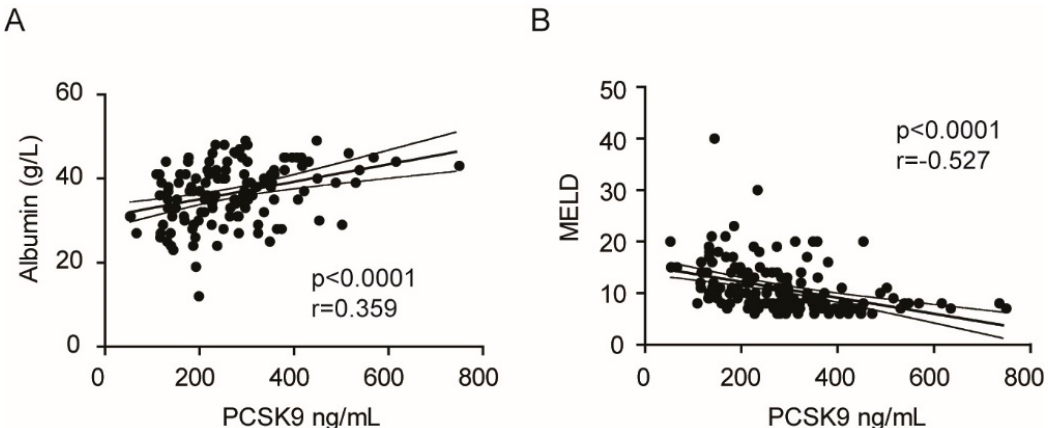
Figure 4. Linear regression analysis PCSK9 and liver functionality. ( A , B ) Linear regression analysis, with a 95% confidence interval, between PCSK9 levels and albumin ( A ) and MELD ( B ).